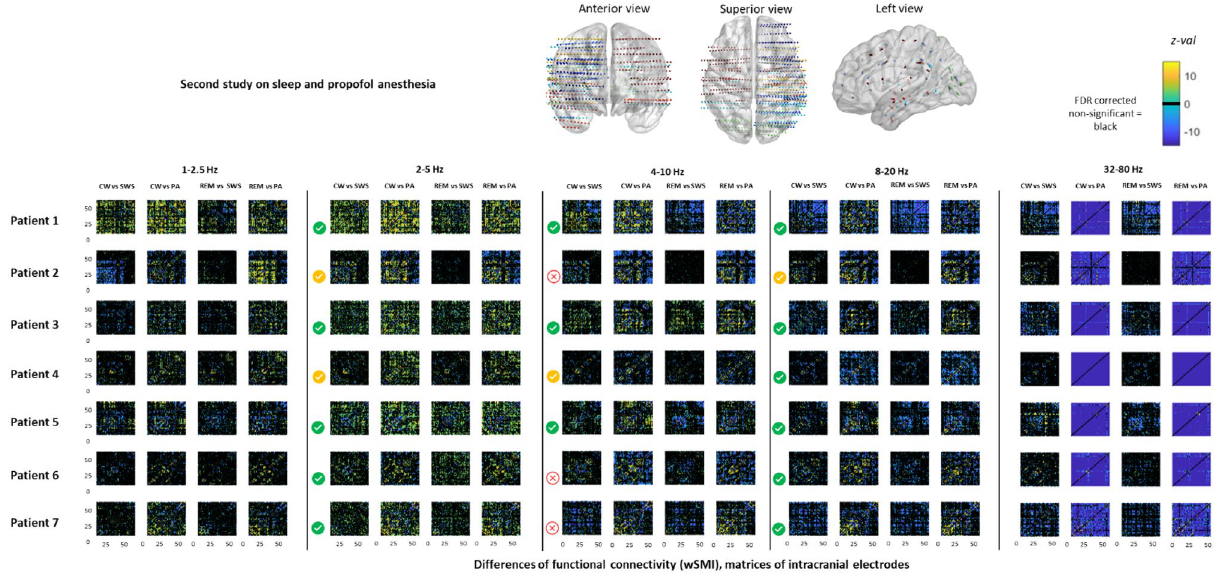
Figure 2. Individual anatomical data and functional connectivity matrices. On the top: Representation in the MNI space of all electrodes implanted in the 7 patients recorded in the four distinct stages (including PA). Each patient is associated to a single colour. On the bottom: Matrices (bipolar derivation × bipolar derivation) showing the z-values of the statistical comparisons between each bipolar derivation across the different stages for three ranges of frequencies: 2–5 Hz; 4–10 Hz, 8–20 Hz; 32–80 Hz. Only significant FDR-corrected z-values are represented. Non-significant effects are plotted in black. CW conscious wakefulness, SWS N3 Slow Wave Sleep, REM rapid eye movement sleep, PA propofol induced general anaesthesia. Symbols show which patients did statistically show the expected pattern in the three frequency bands highlighted by the first experiment: = expected pattern; = expected pattern but with one non-significant comparison; = incongruent to the expected